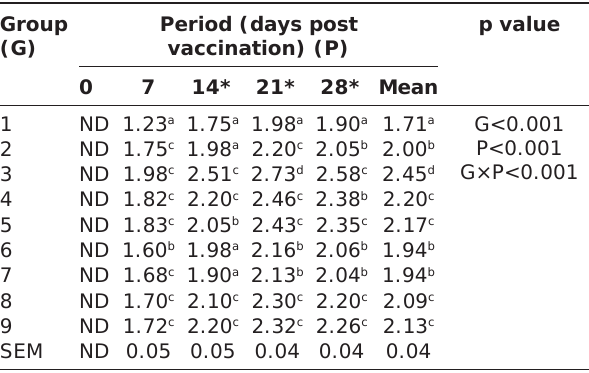
) log STAT titer in the 52 10